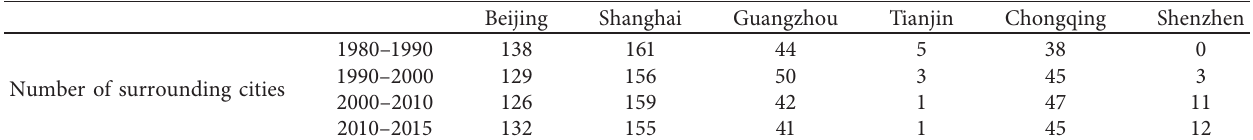
Table 2: Number of cities around six core cities in different